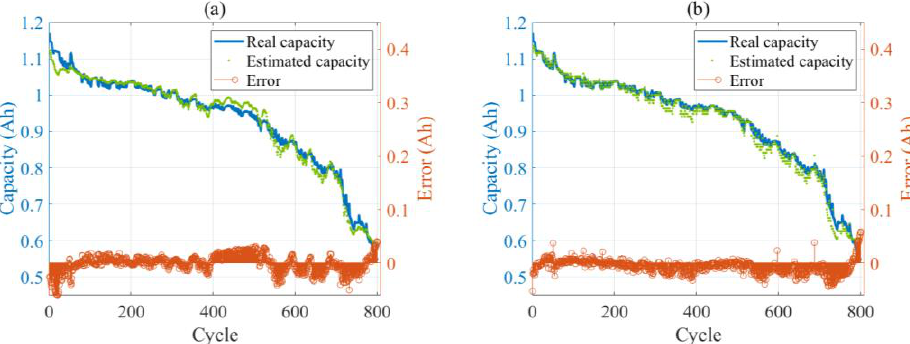
Figure 19. Capacity estimation results of CALCE CS36 3.88 – 3.95V: ( a ) Case 1; ( b ) Case 2.